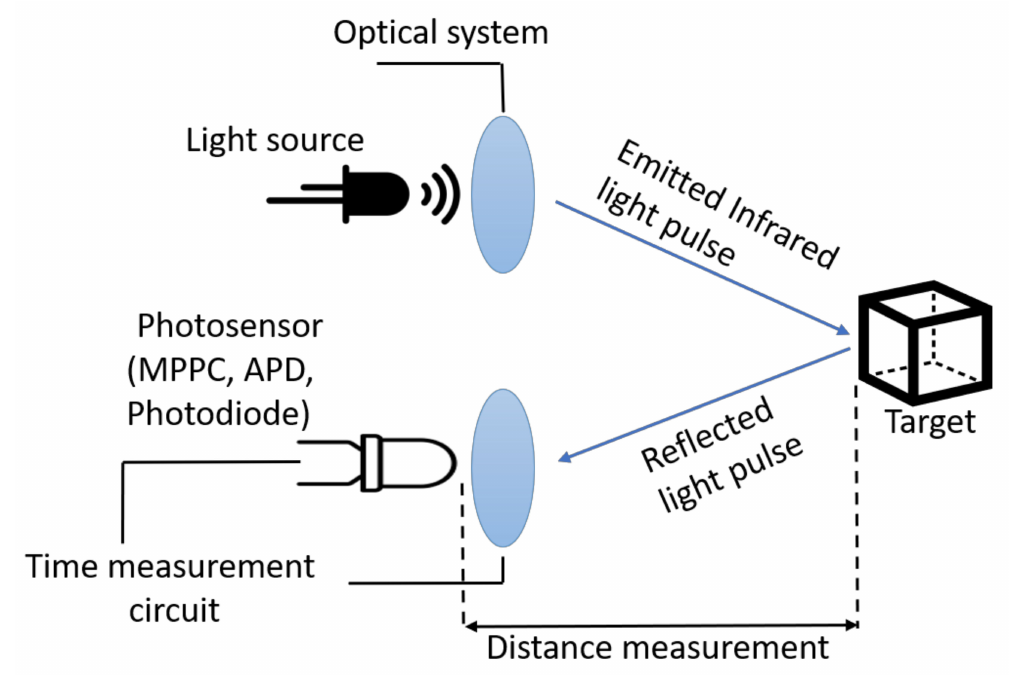
Figure 2. Lidar and time of flight (TOF)